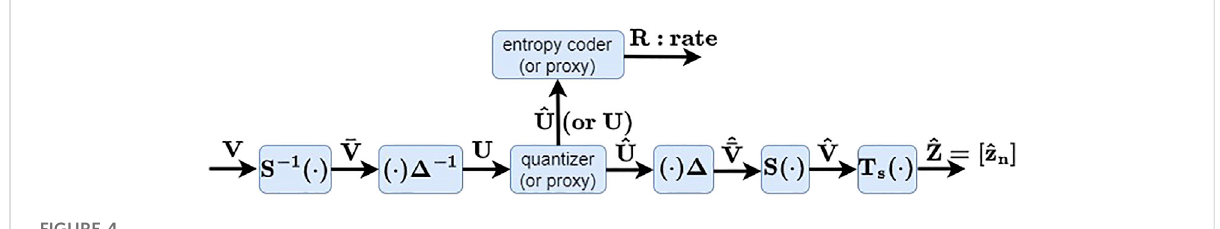
FIGURE 4 LVAC pipeline for compressing latents Z =[ z n ]. Z is represented by difference latents V , normalized by S across levels and blocks to obtain (cid:2) V , divided bystep sizes Δ across channels to obtain U , quantized byrounding to obtain ^ U (cid:1) (cid:3) U (cid:4) , and reconstructed as ^ Z (cid:1) T s S ^ U Δ . V (or equivalently (cid:2) V in practice) is optimized by back-propagating through D ( θ , Z )+ λ R ( θ , Z ) and the pipeline using differentiable proxies for the quantizer and entropy